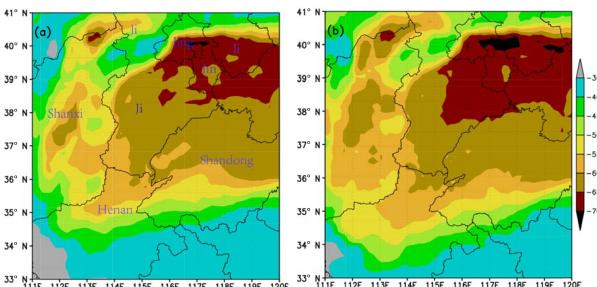
Figure 5. Mean percentage change in the SDSRF (W − 1 m − 2 ) ow- ing to (a) aerosols and (b) aerosols + the decrease in the turbulent diffusion coefficient during the explosive growth stage.